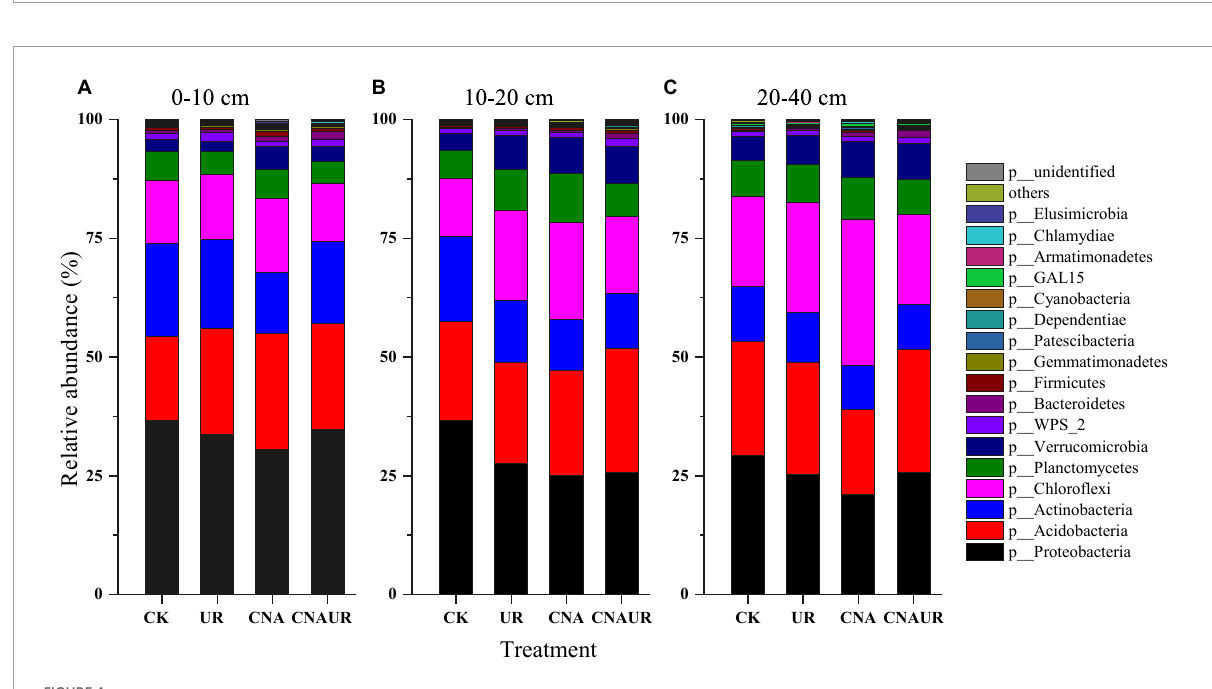
FIGURE4 Relative abundance of soil bacterial community at the phyla level under treatments (treatments are described in Table 1 ) in three soil layers, 0–10 cm (A) , 10–20 cm (B) , 20–40 cm (C) . Those phyla that represent > 0.1% of the bacterial community abundance are named, while those that represent < 0.1% of the bacterial community abundance are referred to as